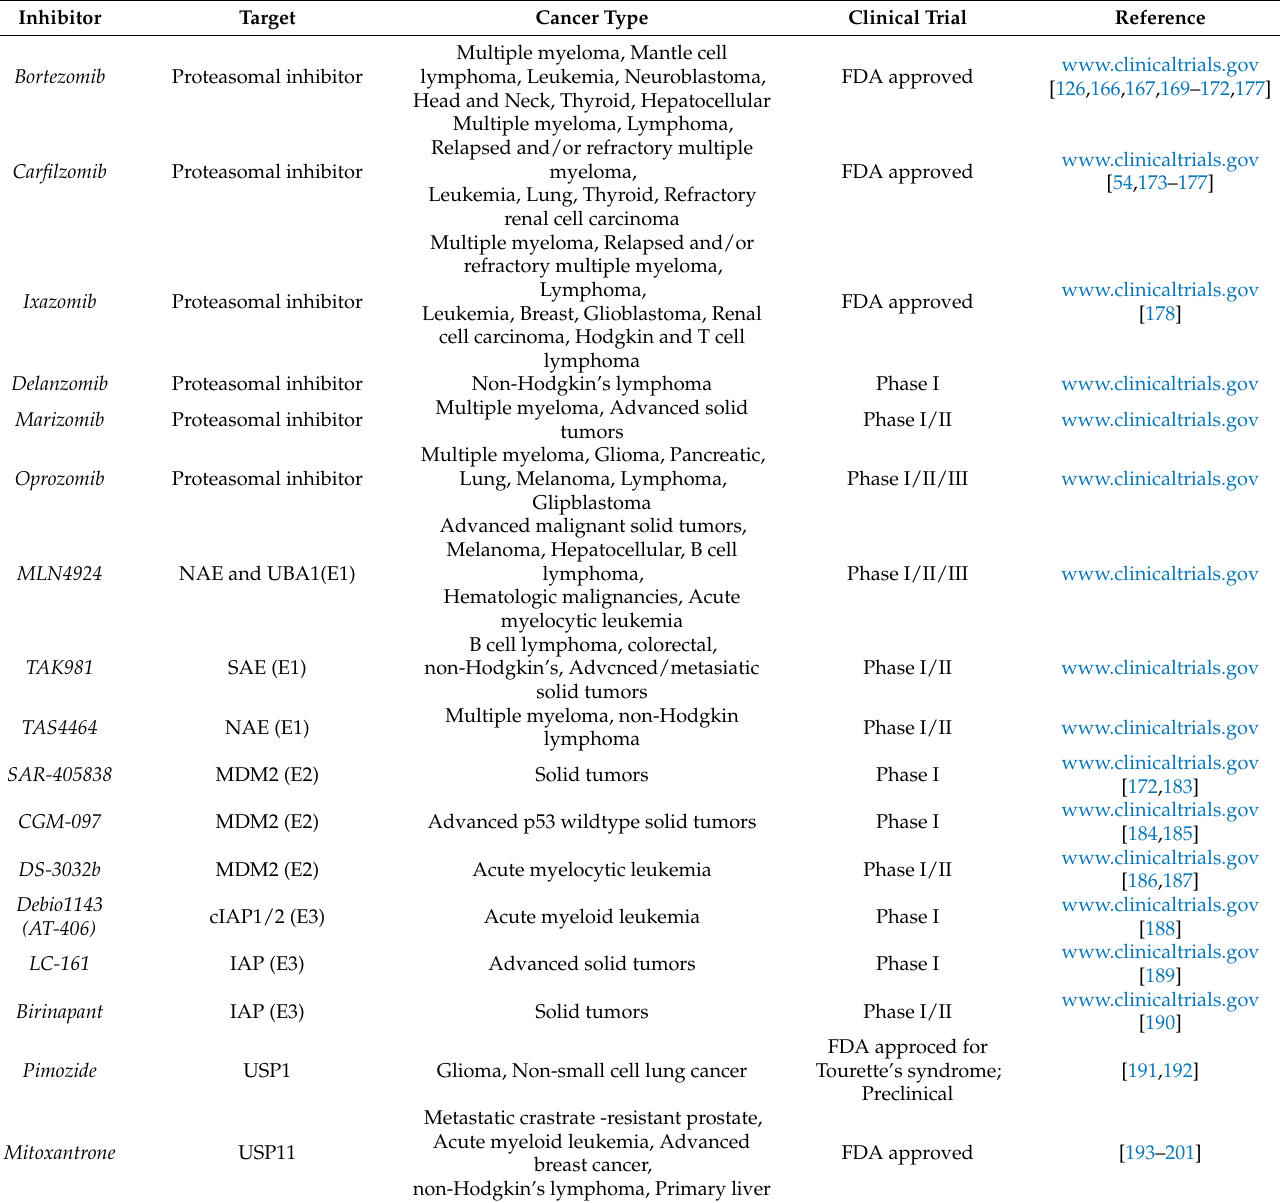
Table 3. Summary of UPS inhibitors which are FDA-approved and/or tested in clinical trials described in this review. Inhibitor Target Cancer Type Clinical Trial